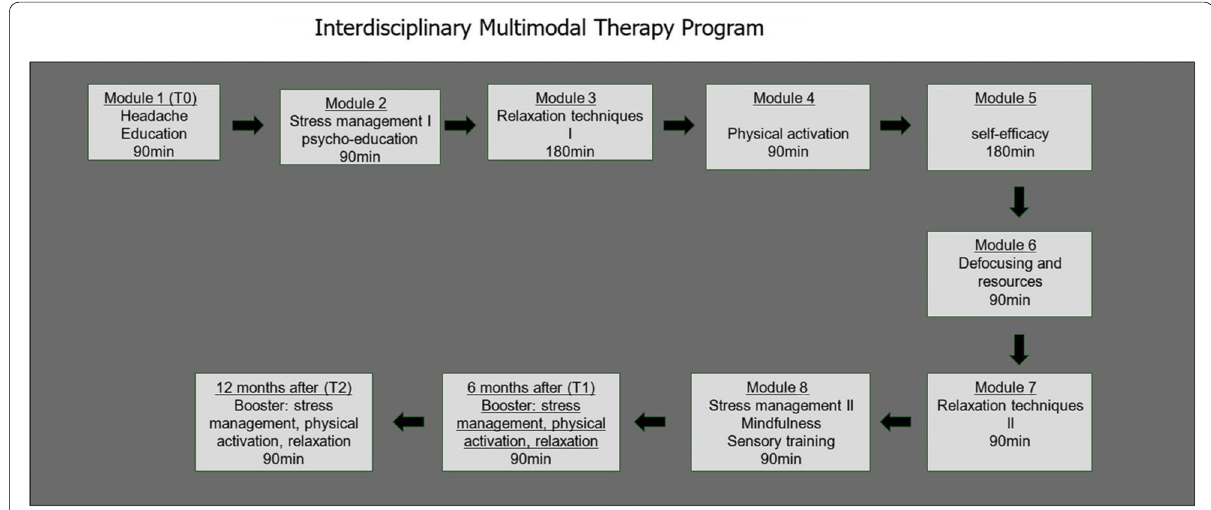
Fig. 1 Overview of the interdisciplinary multimodal group therapy